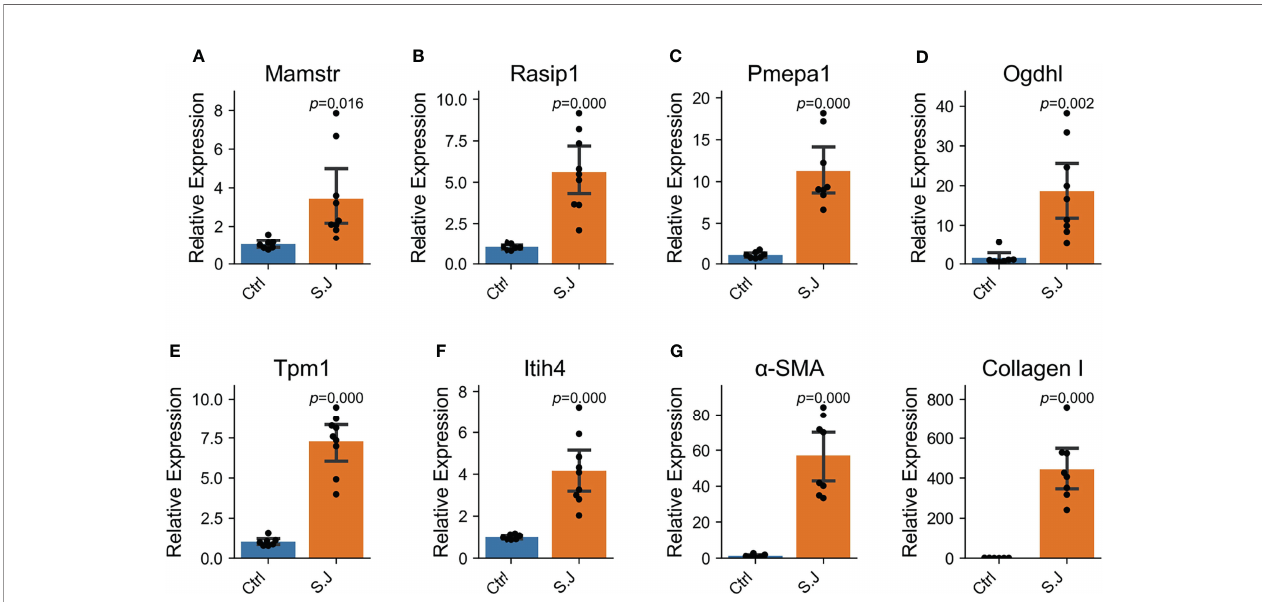
FIGURE 4 | Six schistosomiasis-associated genes were up-regulated in the liver of mice with severe schistosomiasis. Expression levels of genes were determined by qRT-PCR in normal and S. japonicum infected liver (n = 8 per group). Bar and error bar represent mean and 95% con fi dence intervals, respectively. A two-tailed Student T-test was used for statistical analysis. (A, B) Mamstr and Rasip1 , the associated genes of aspartate aminotransferase (AST). (C) Pmepa 1, the associated gene of hyaluronic acid (HA). (D) Ogdhl , the associated gene of ascites grade. (E) Tpm1 , the associated gene of albumin. (F) Itih4 , the associated gene of Portal vein diameter (PVD). (G) a -SMA and Collagen I was the index re fl ecting the degree of liver fi brosis in mice with